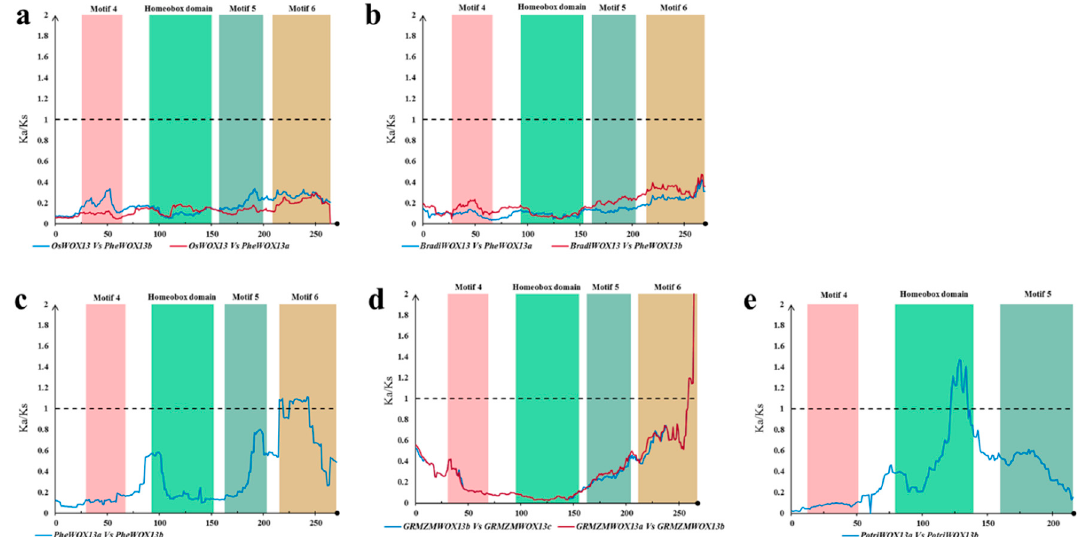
Figure 4. Sliding window of the WOX13 genes of the ancient clade. ( a ) The sliding window of orthologous WOX13s between P. edulis and Oryza sativa . ( b ) The sliding window of orthologous WOX13s between P. edulis and Brachypodium distachyon . ( c – e ) The sliding window of paralogous WOX13s of P. edulis , Zea mays , and Populus trichocarpa , respectively.